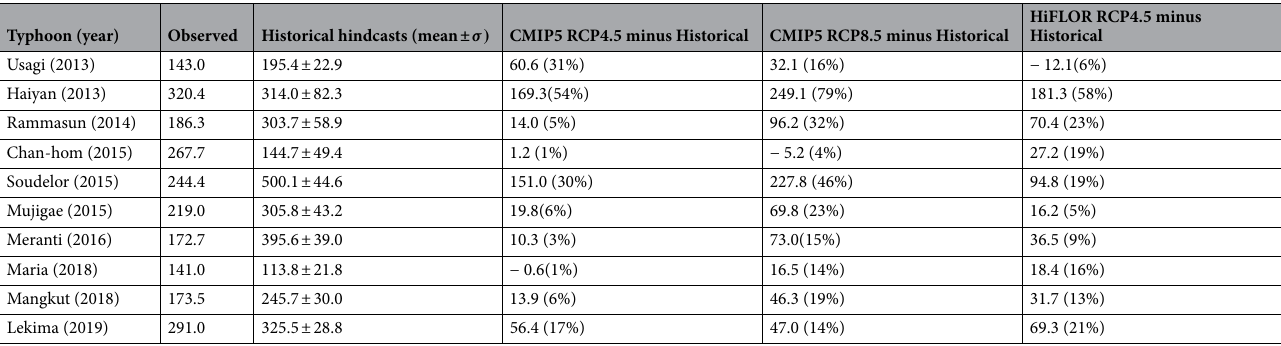
Table 2. Maximum daily precipitation at landfall